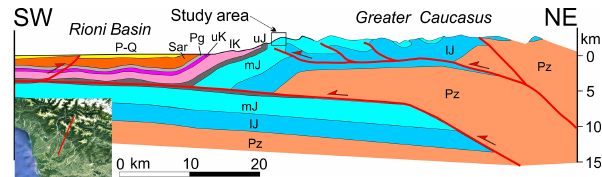
Figure 2. Structural section passing through the study area (box), obtained by integrating our field surveys with geophysical and geo- logical data from Banks et al. (1997). Note the presence of a main basal thrust dipping north, which shows a ramp–flat geometry that produced a frontal asymmetric ramp